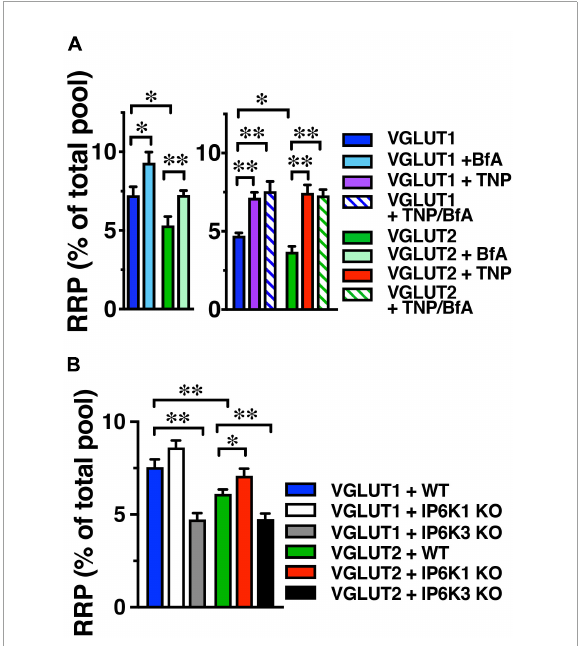
FIGURE3 IP6K inhibition increases VGLUT-pHs in the RRP. (A) The fraction of VGLUT1 and 2-pH that undergoes exocytosis in response to a 100 Hz 20 AP stimulus to release the RRP is larger in the presence of BfA (left) and TNP (right). There is no additive effect of TNP and BfA. BfA increases the amount of VGLUT1- and 2-pH in the RRP to a lesser extent than TNP. Data are means ± SEM of (cid:49) F/F 0 normalized to total fluorescence over at least 35 boutons per coverslip from 9 to 12 coverslips per construct and at least three independent cultures for both experiments. (B) IP6K1 KO does not significantly increase VGLUT2-pH in the RRP, while IP6K3 KO decreases VGLUT1- and 2-pH in the RRP. Data are means ± SEM of (cid:49) F/F 0 normalized to total fluorescence over at least 40 boutons per coverslip from 6 to 12 coverslips per construct and at least three independent cultures. ∗ p < 0.05, ∗∗ p < 0.01,